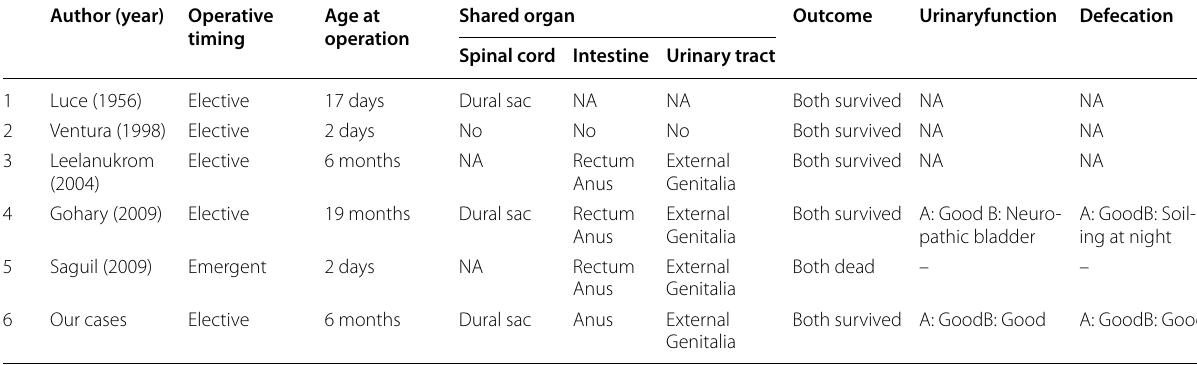
Table 1 Male pygopagus conjoined